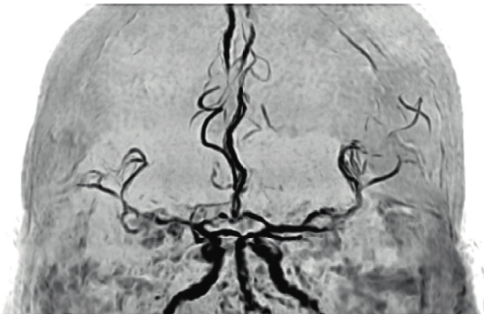
Figure 4: MRA: stenosis at distal M1 segment of the right middle cerebral